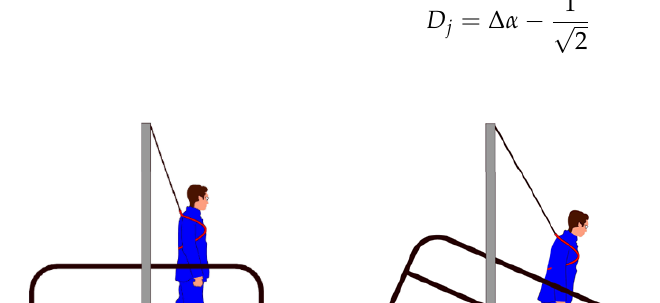
Figure 7. Dynamic coefficient of friction measurement: ( a ) PO series in dry condition, ( b ) flamed (PL) series in wet condition.